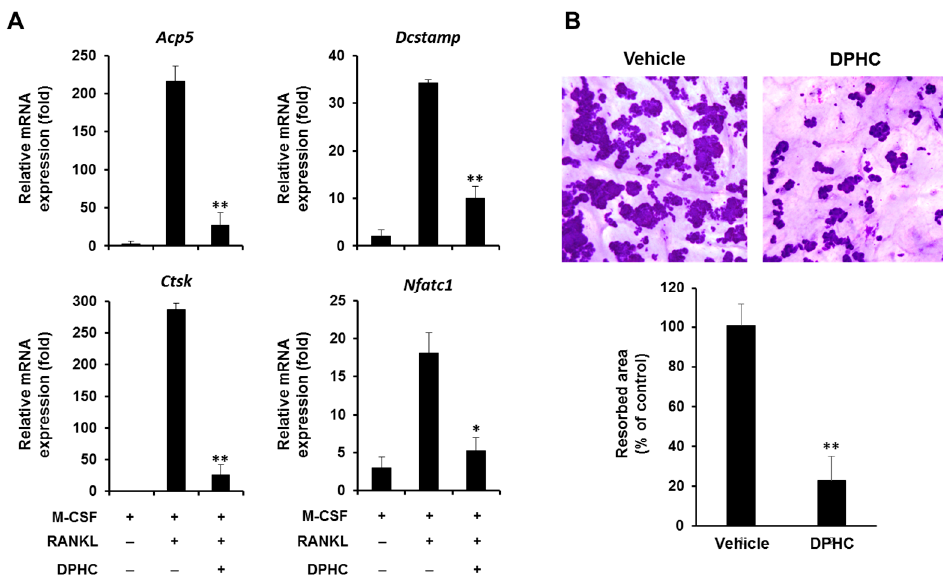
Figure 4. Effects of DPHC on RANKL-induced gene expression and the formation of resorption pits. ( A ) BMMs were cultured with M-CSF (10 ng/mL) and RANKL (20 ng/mL) for four days in the absence or presence of DPHC (75 μ g/mL). The mRNA expression of TRAP ( Acp5 ), DC-STAMP ( Dcstamp ), Cathepsin K ( Ctsk ), and NFATc1 ( Nfatc1 ) was analyzed using real-time PCR; ( B ) Mouse BMMs were seeded on bone slices and cultured with M-CSF (10 ng/mL) and RANKL (20 ng/mL) for three days to induce osteoclast differentiation from BMMs. Further, the cells were treated with or without DPHC (75 μ g/mL) for two days. The resorption pits were stained with hematoxylin solution, and stained areas were measured; * p < 0.05; ** p < 0.01 versus vehicle-treated control.